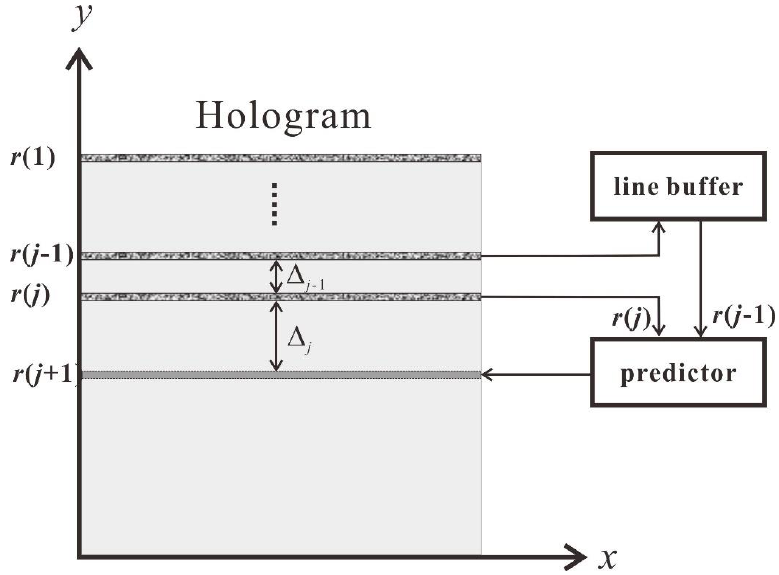
Figure 7. Schematic of the concept of adaptive optical scanning holography (AOSH).